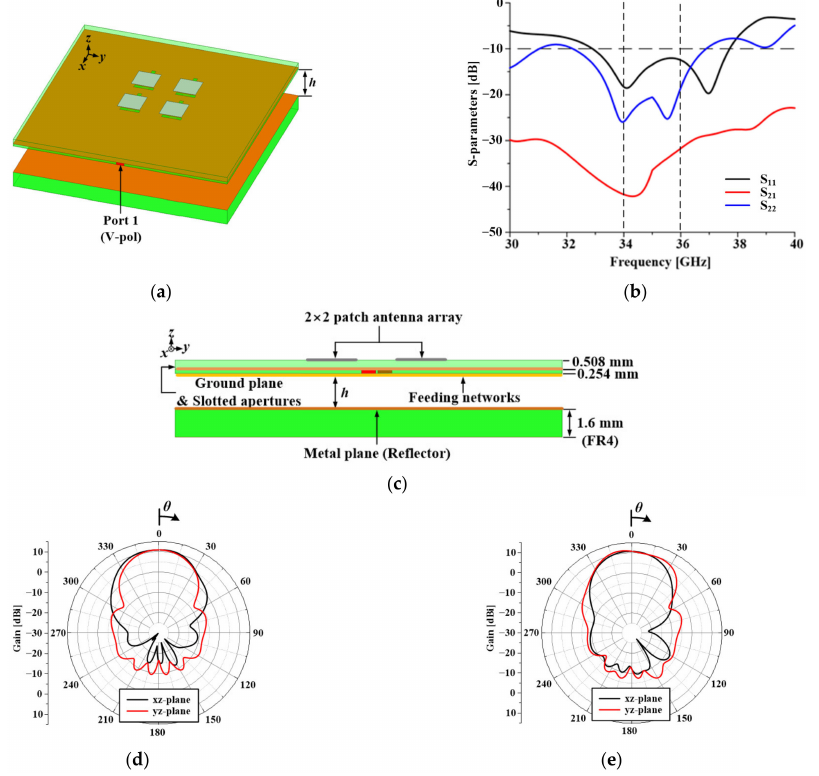
Figure 5. 2 × 2 patch antenna array with feeding network and reflector: ( a ) geometry of antenna array with reflector, ( b ) simulated S-parameters when h = 3 mm, ( c ) side view, ( d ) simulated radiation patterns at 35 GHz when Port 1 is excited ( h = 3 mm), and ( e ) simulated radiation patterns at 35 GHz when Port 2 is excited ( h = 3